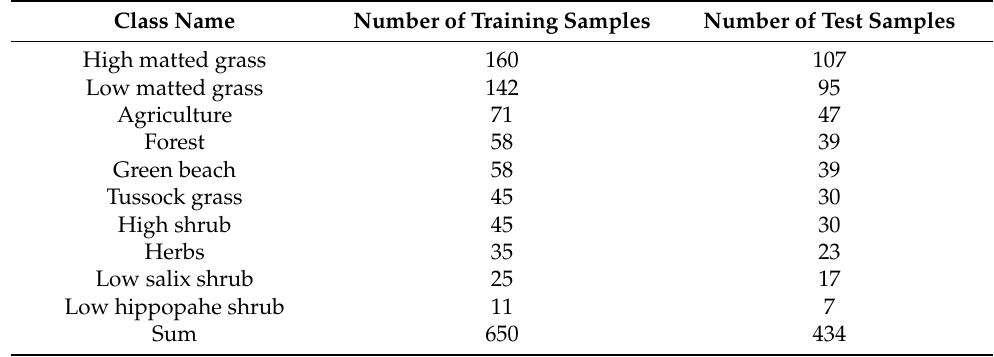
Table 1. The vegetation classes in Schiermonnikoog Island and the number of their collected samples. Class Name Number of Training Samples Number of Test Samples High matted grass